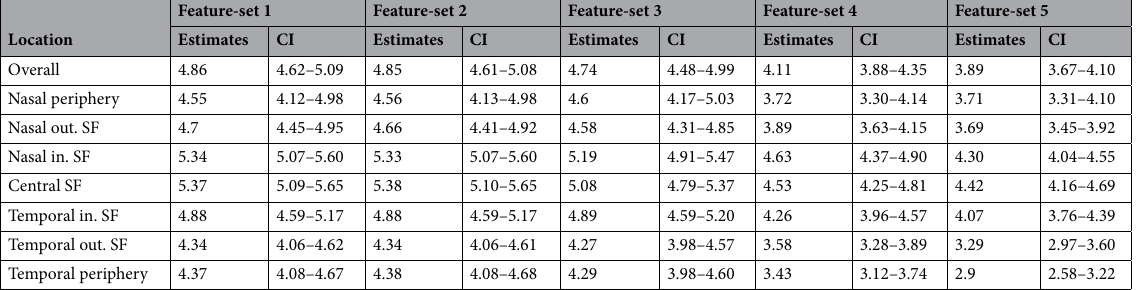
Table 2. Mean absolute errors (MAE [in dB]) between retinal sensitivity predictions and observation. CI confidence interval, Out outer, In inner, SF ETDRS subfield, Nasal periphery test-points nasal to the outer nasal SF, Temporal periphery test-points temporal to the outer temporal